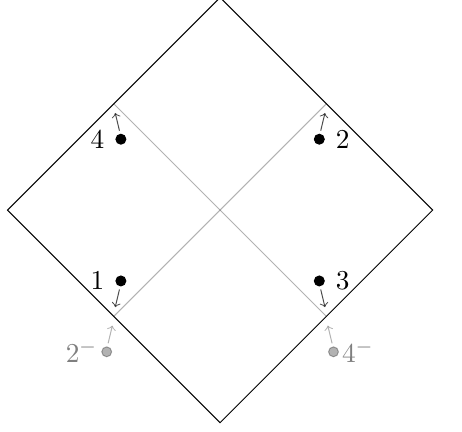
and x 3 ! x (cid:0) . The points x (cid:0) ; x (cid:0) 2 4 2 4